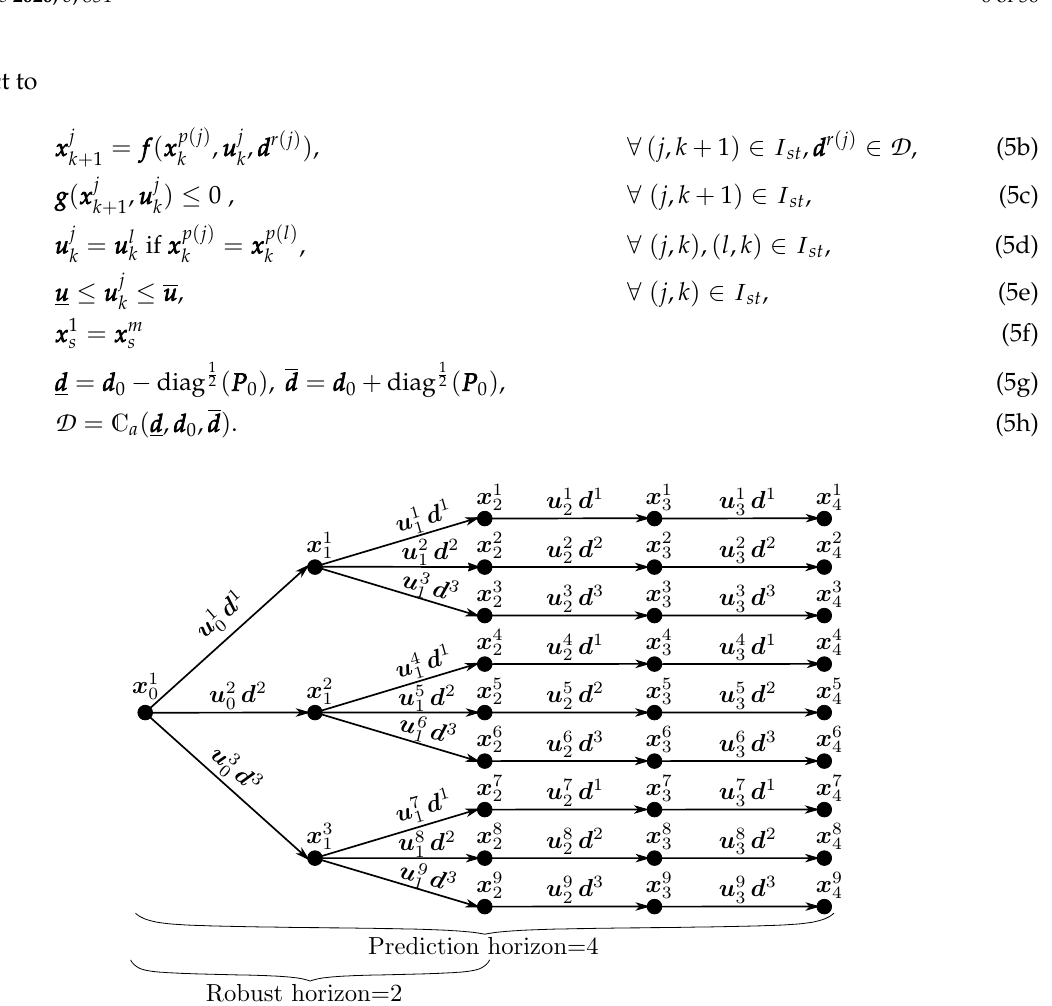
1 Figure 2. Scenario tree of the multi-stage